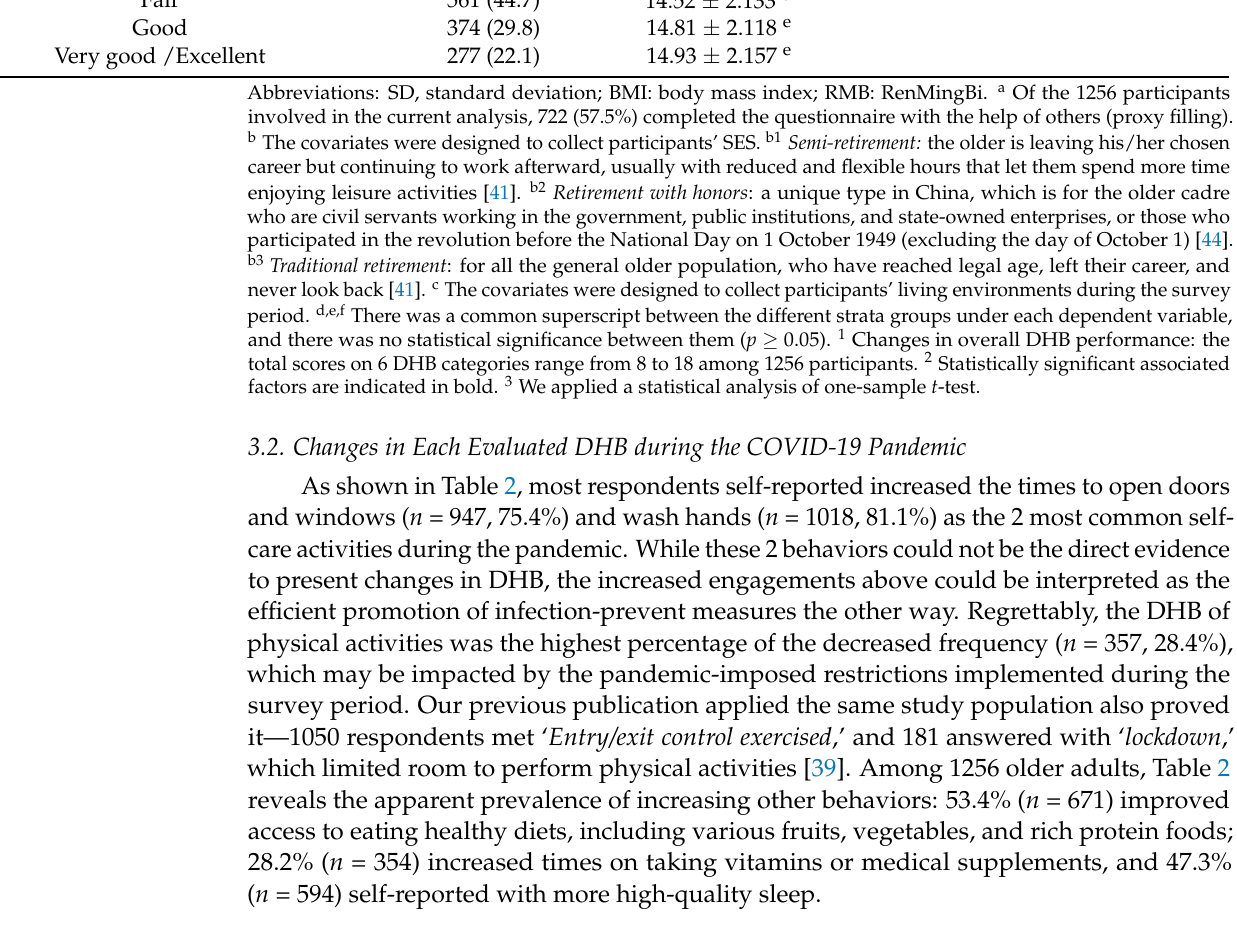
Table 2. Changes on DHB performance among older Chinese in the past week ( n =